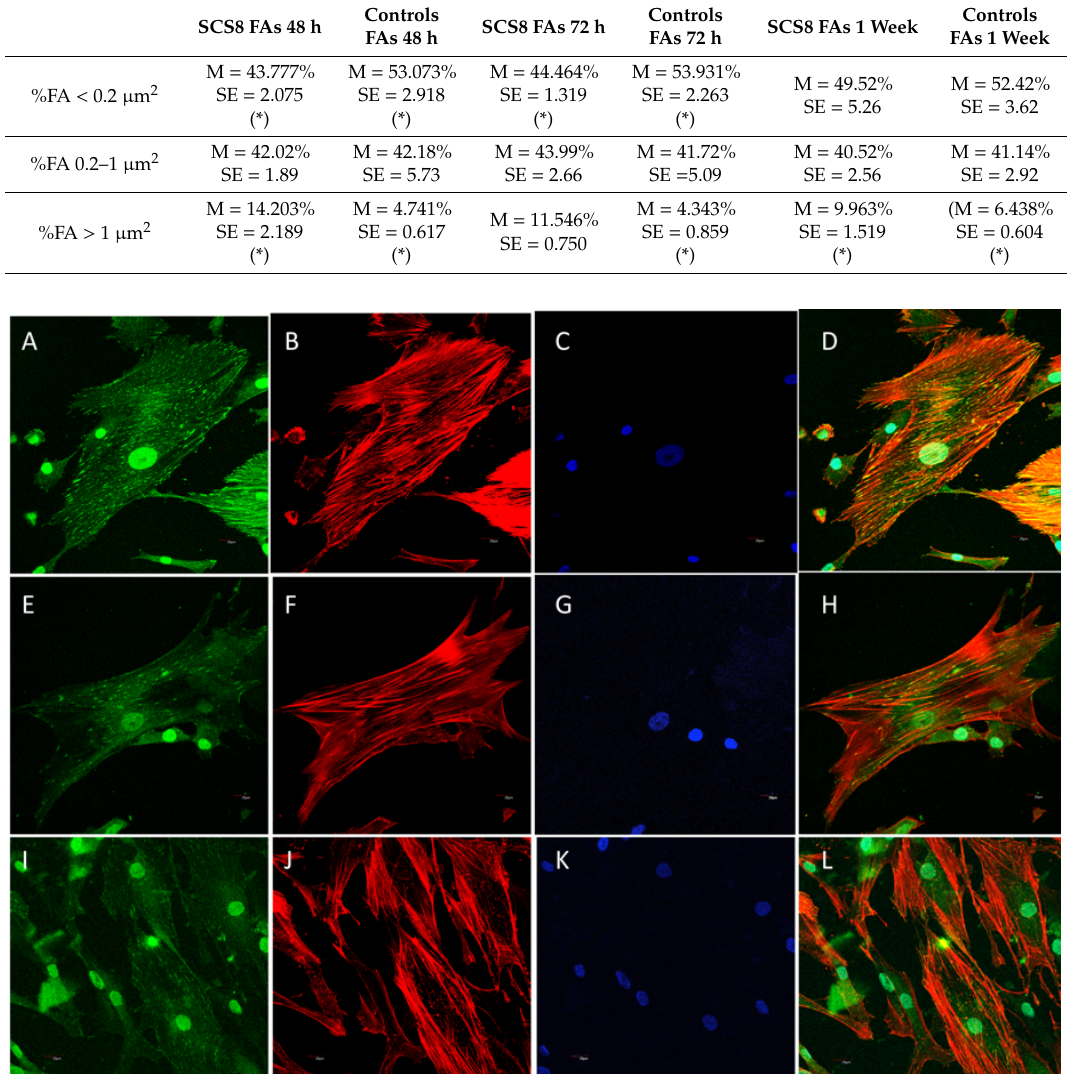
Table 5. Percentage of focal adhesions compared by size and time. Statistically significant di ff erences are labeled with an asterisk (*), p < 0.05. (M = mean and SE = standard error).